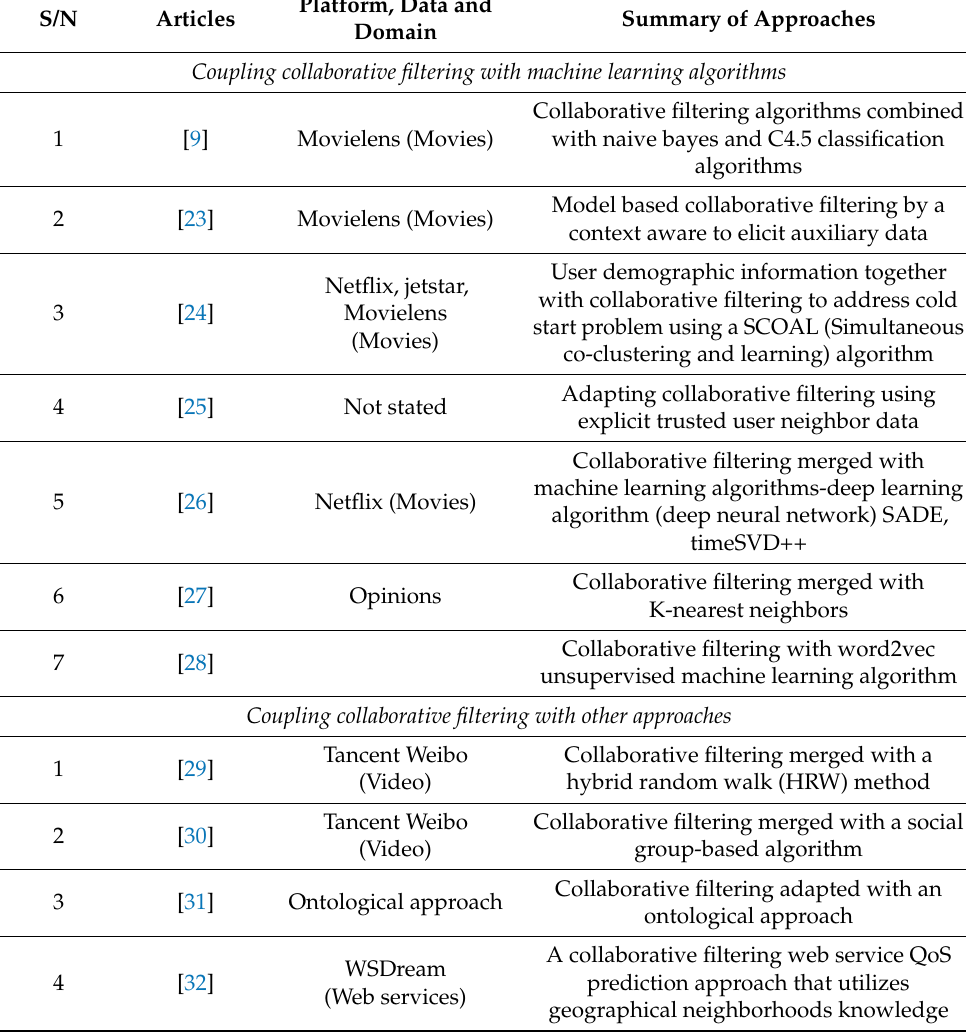
Table 1. Adapting traditional filtering